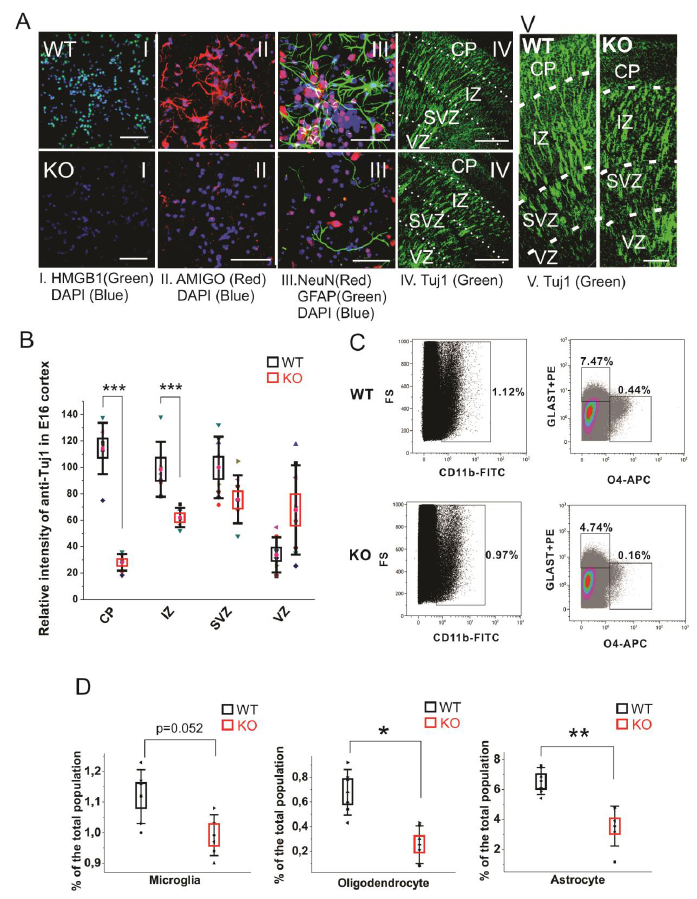
Figure 4. Cell differentiation activity in the WT and HMGB1 KO. ( A ) E16 cortical neuronal cells cultured for 7 days. (A I) Anti-HMGB1 staining (Green). (A II) Anti-AMIGO1 staining (Red). (A III) Anti-GFAP (Green) and anti-NeuN (Red) staining. DAPI (Blue) was used for labeling cell nuclei in (A I–III) Scale bar indicates 50 µ m. IV, Anti- β -Tubulin III (Tuj1) staining of E16 sagittal sections. Scale bar indicates 400 µ m. (A V) Anti- β -Tubulin III (Tuj1) staining of E16 sagittal sections. Scale bar indicates 100 µ m. (I–V) are the confocal z-stack max projections of 10 µ m. ( B ) Statistics of Tuj1 fluorescent staining intensity in the WT and HMGB1 E16 dorsal telencephalon. The HMGB1 KO showed significantly decreased Tuj1 staining in CP and IZ layers compared to the WT. The HMGB1 KO showed higher Tuj1 staining in VZ than the WT. Statistics has been done by the six brain sections from three embryos for both WT and KO. Mean values ± S.D. (error bars) and S.E.M (boxes) are indicated ( n = 6; *** p < 0.001, unpaired t -test, two-tailed). ( C ) Flow cytometry analyses of CD11b + microglia cells, GLAST-PE + astrocytes, and O4-APC + oligodendrocytes in the E16 WT or HMGB1 KO brains. Each sample was prepared from one single brain. The ratio of each type of cells among the total cell population was then calculated. ( D ) Statistics analysis of Flow cytometry results of the WT and KO mouse brains. The HMGB1 KO mouse brain showed significantly reduced population of oligodendrocytes and astrocytes compared to the WT controls. Statistics is based on the data from 8 WT and 8 KO brains. Mean values ± S.D. (error bars) and S.E.M (boxes) are indicated ( n = 8; ** p < 0.01; * p < 0.05, unpaired t -test,